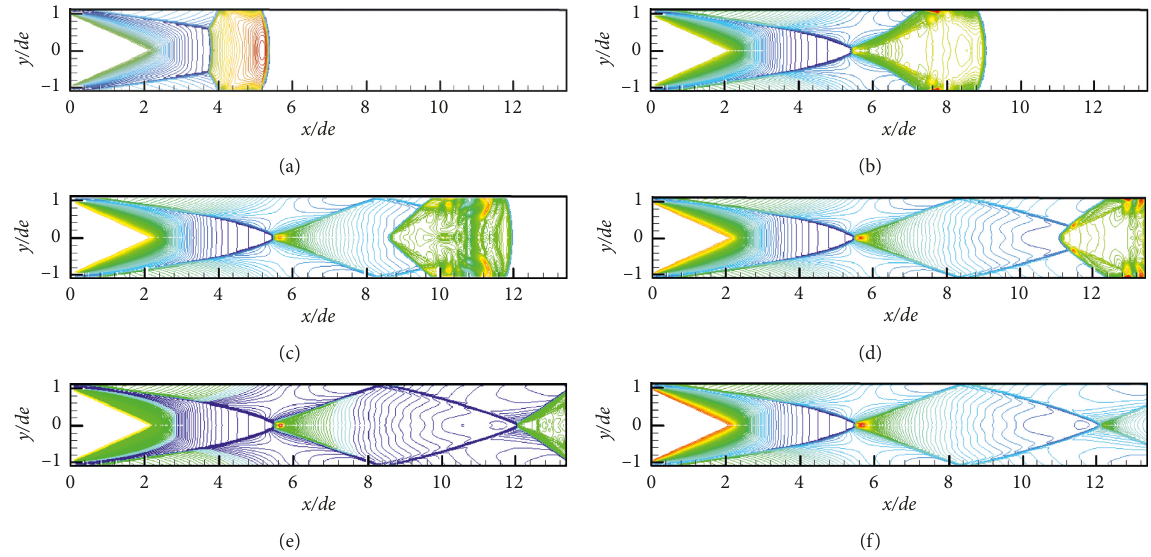
Figure 4: Density contour at different times of 1/4 direction pipe length. (a) t � 1.4ms. (b) t � 2.8ms. (c) t � 4.2ms. (d) t � 4.9ms. (e) t � 5.6ms. (f) t � 7ms.